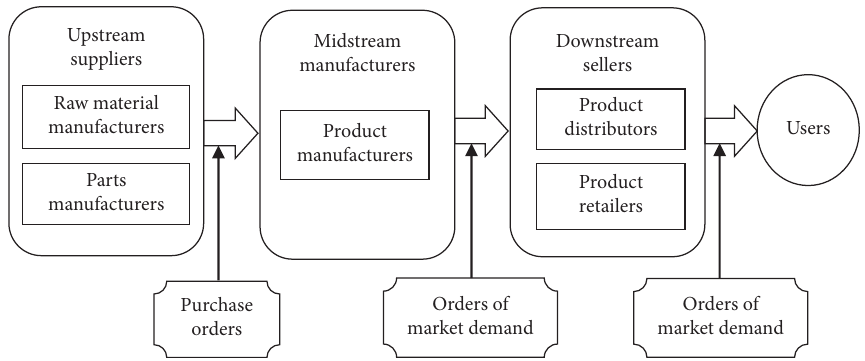
Figure 1: Supply chain mode oriented by manufacturing